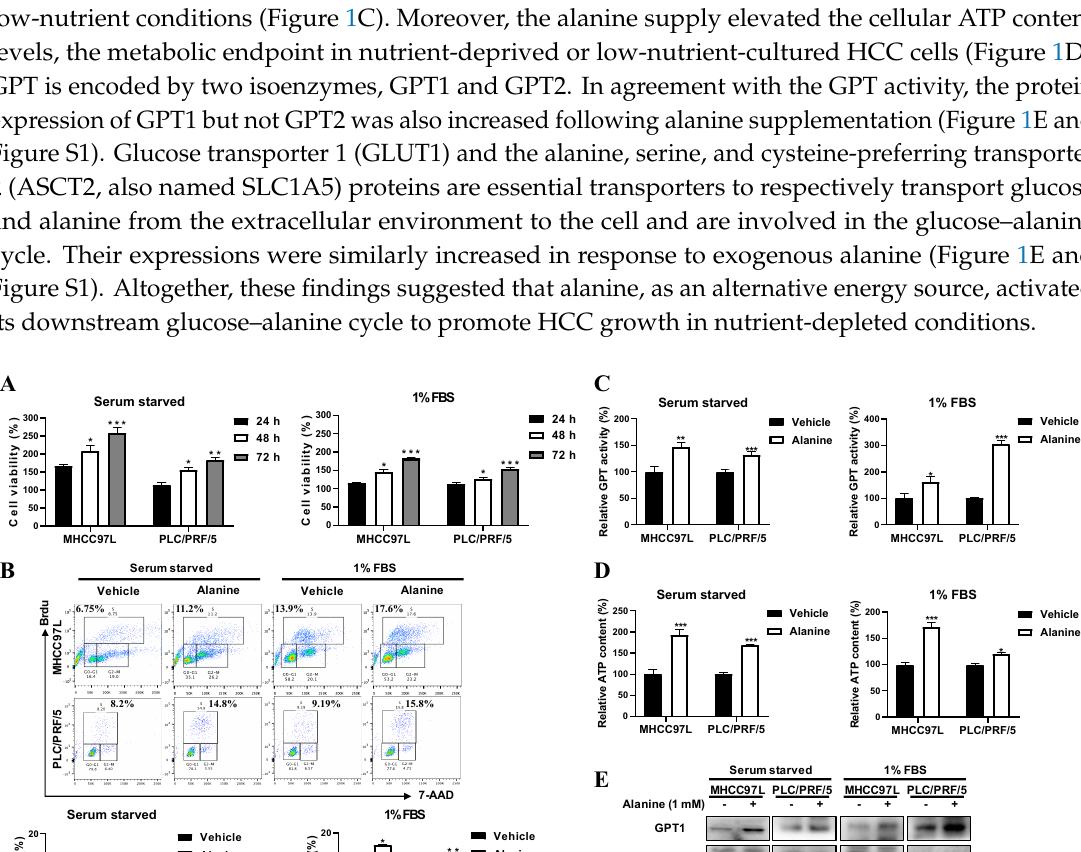
Figure 1. Alanine as an alternative energy source activated its downstream glucose–alanine cycle to promote HCC (hepatocellular carcinoma) growth in nutrient-depleted conditions. ( A ) The cell viability analysis of MHCC97L and PLC / PRF / 5 cells under nutrient-deprived or low-nutrient-culture conditions following alanine supplementation for 24, 48, and 72 h. ( B ) The BrdU incorporation analysis of MHCC97L and PLC / PRF / 5 cells under nutrient-deprived or low-nutrient-culture conditions following alanine supplementation for 24 h. ( C ) The GPT (glutamic-pyruvic transaminase) activity levels of MHCC97L and PLC / PRF / 5 cells under nutrient-deprived or low-nutrient-culture conditions following alanine supplementation for 24 h. ( D ) The ATP (adenosine triphosphate) content levels of MHCC97L and PLC / PRF / 5 cells under nutrient-deprived or low-nutrient-culture conditions following alanine supplementation for 24 h. ( E ) The representative Western blot panels of GPT1, GPT2, ASCT2 (alanine, serine, and cysteine-preferring transporter 2), and GLUT1 (glucose transporter 1) protein levels in MHCC97L and PLC / PRF / 5 cells under nutrient-deprived or low-nutrient-culture conditions following alanine supplementation for 24 h. All experiments were conducted in triplicate unless otherwise stated. * P < 0.05, ** P < 0.01, *** P <